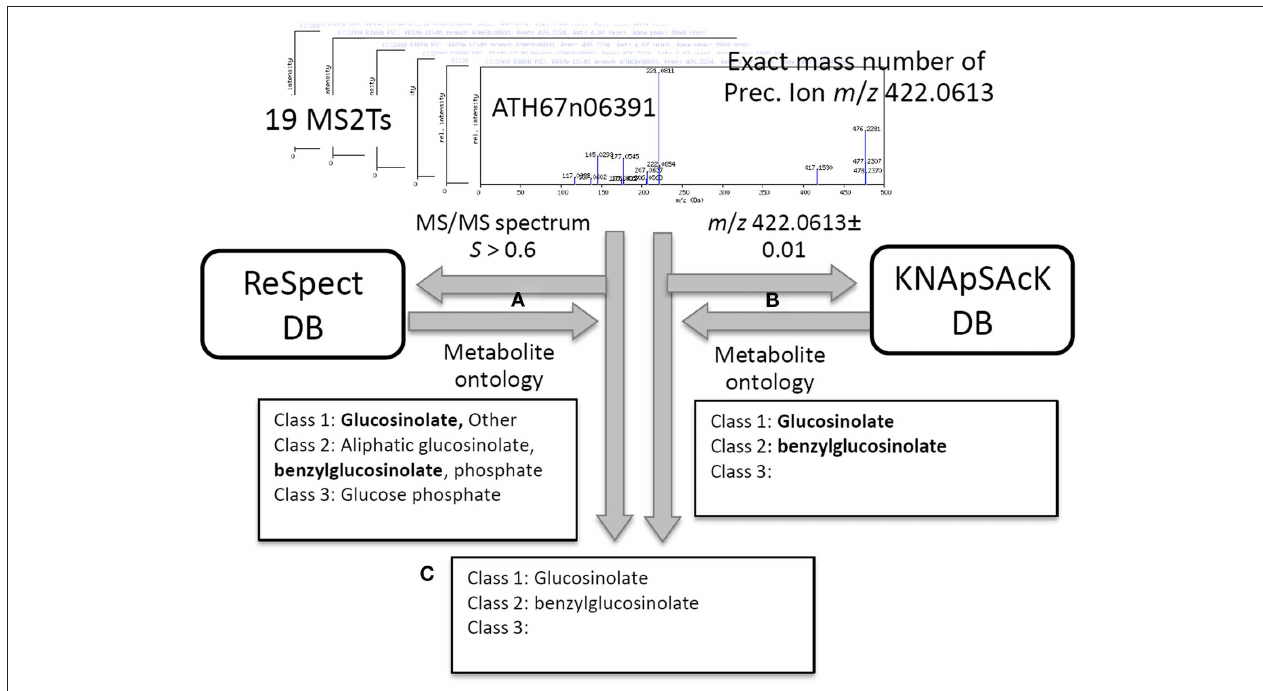
Figure 3 | Procedure for putative characterization of metabolite signal using metabolite ontology. For 19 MS2T accessions tagged to the metabolite signal, aen008844, MS/MS spectra data and the exact mass number were used for ReSpect (A) and KNApSAcK (B) searches. The